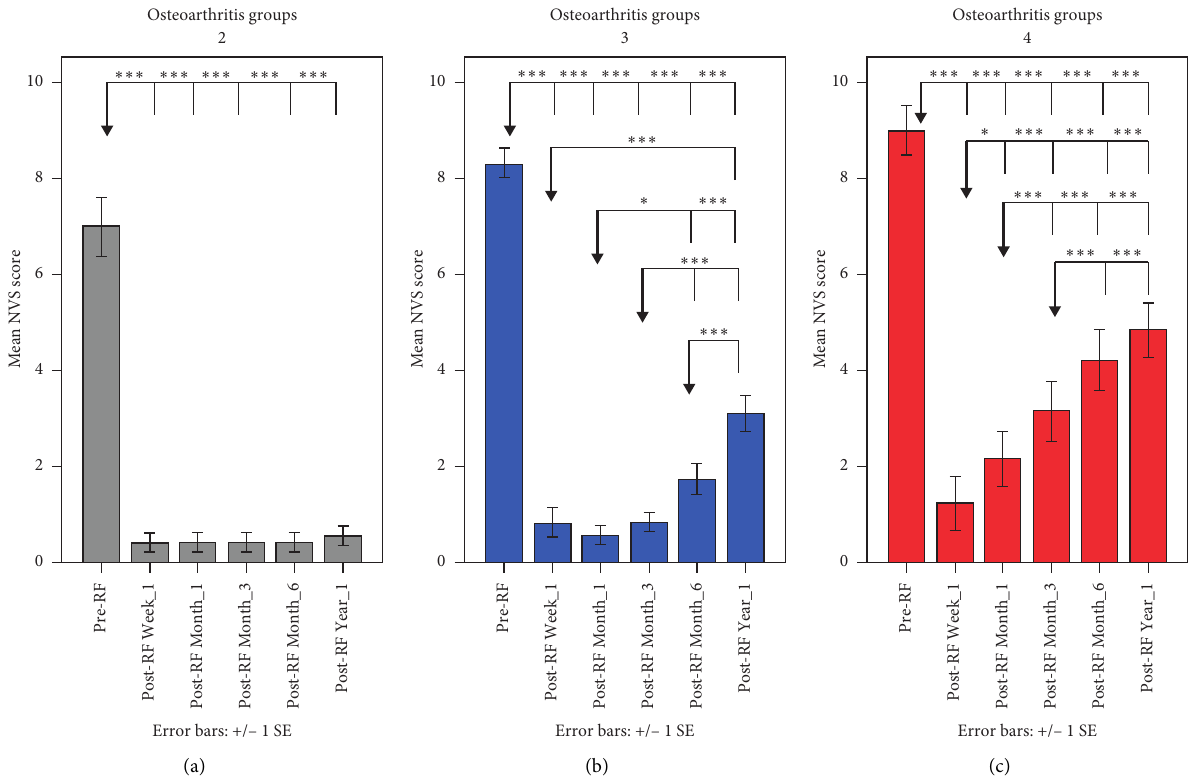
Figure 4: Bar charts illustrating mean NVS scores and standard error (1SE) prior and during the follow-up period within each osteoarthritis group (note: the reference point for each comparison is indicated with a grey arrow; ∗∗∗ p < 0 . 005, ∗∗ p < 0 . 01, and ∗ p < 0 . 05 after Bonferroni